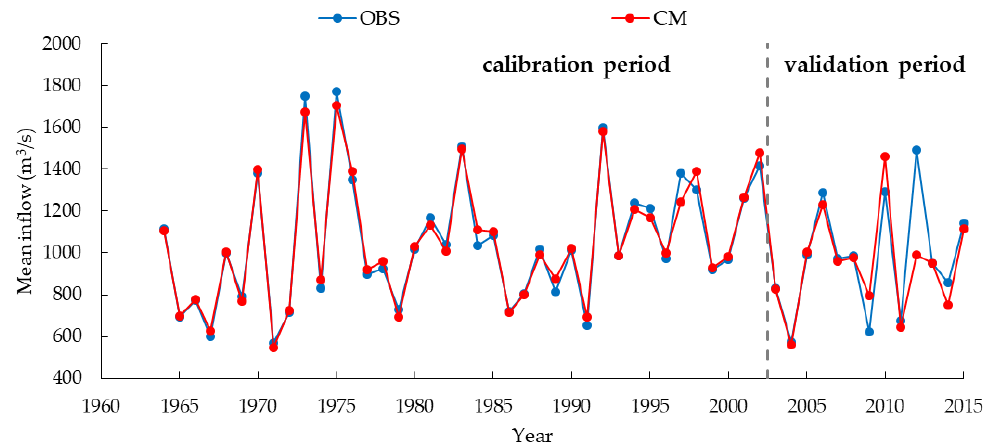
Figure 7. Prediction results of the coupling model (note: OBS represents the observed value, CM